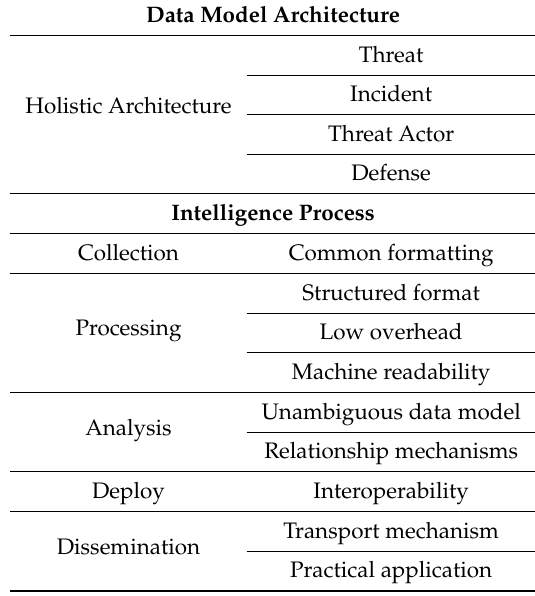
Table 2. Evaluation criteria for Cyber Threat Intelligence (CTI) standards.